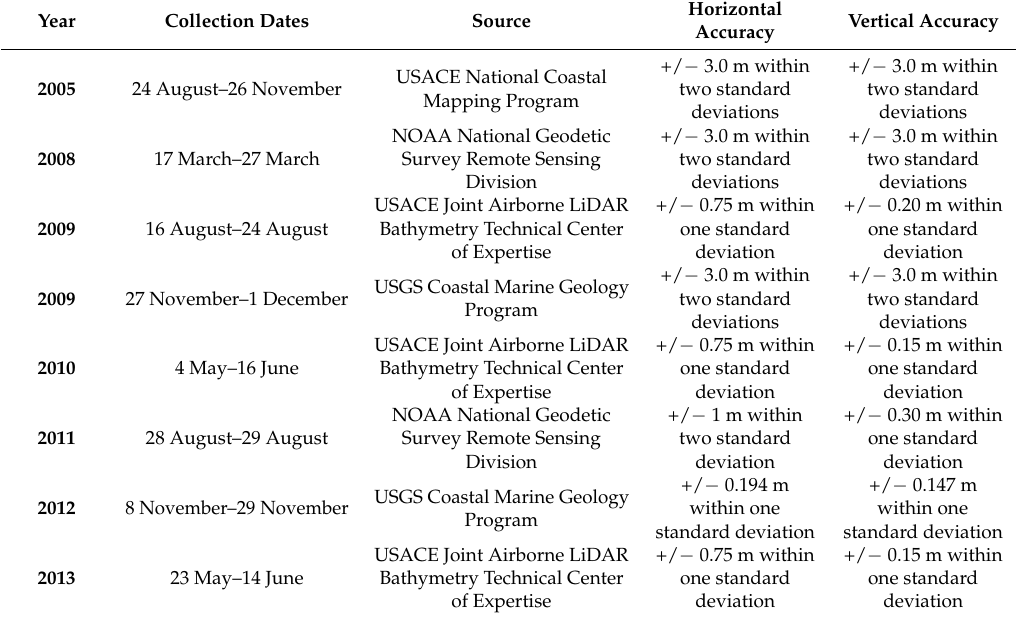
Table 2. Lidar data sources and